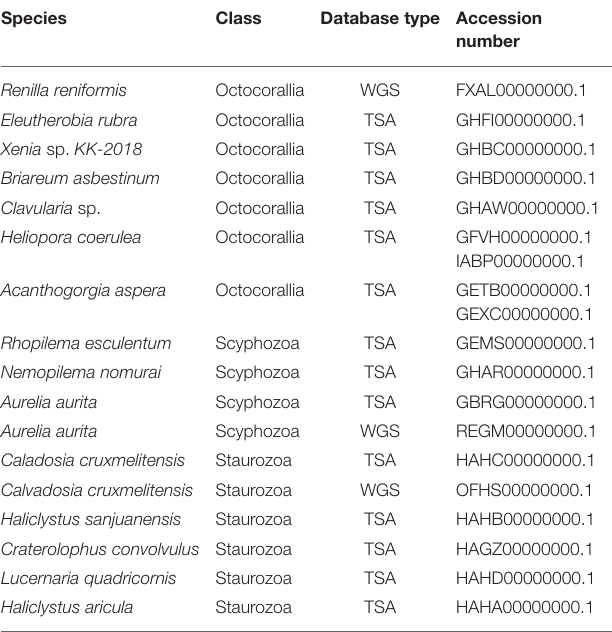
TABLE 1 | Accession numbers for the different databases